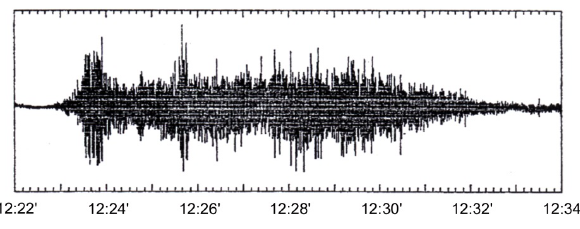
Fig. 17 ‐ Seismogram recorded at Cavalese station on 19 th July 1985, from 12:22’ to 12:34’. Fig. 17. Seismogram recorded at Cavalese station on 19 July 1985, from 12:22 to